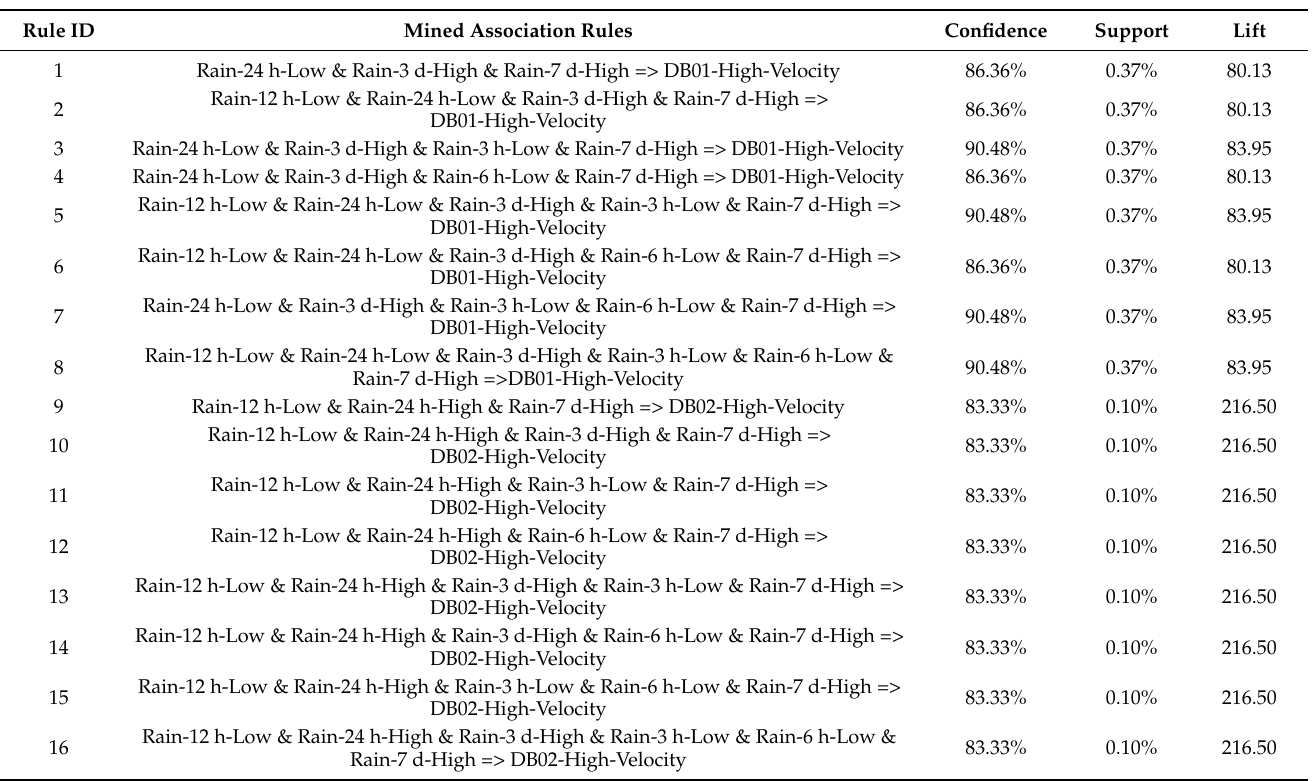
Table 3. Association rules related to Lishanyuan landslide